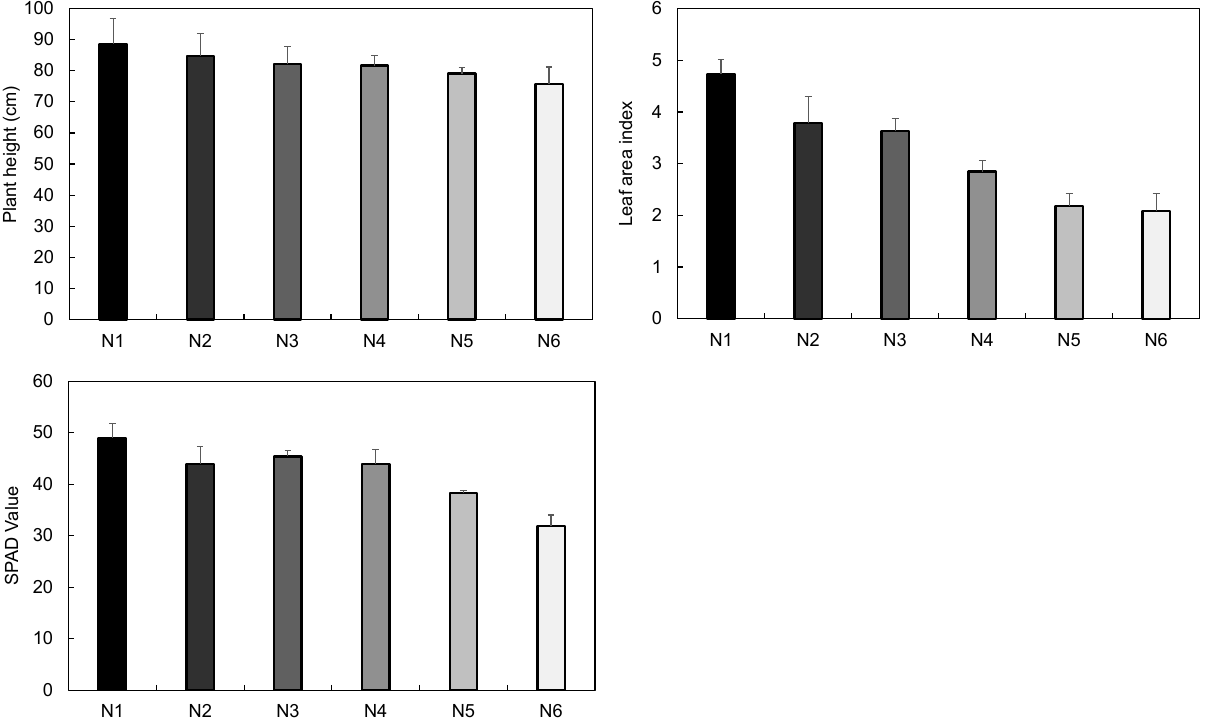
Figure 1. Plant height, leaf area index (LAI), and SPAD value measured on 19 April 2019 in wheat plants with different N top–dressing rates.